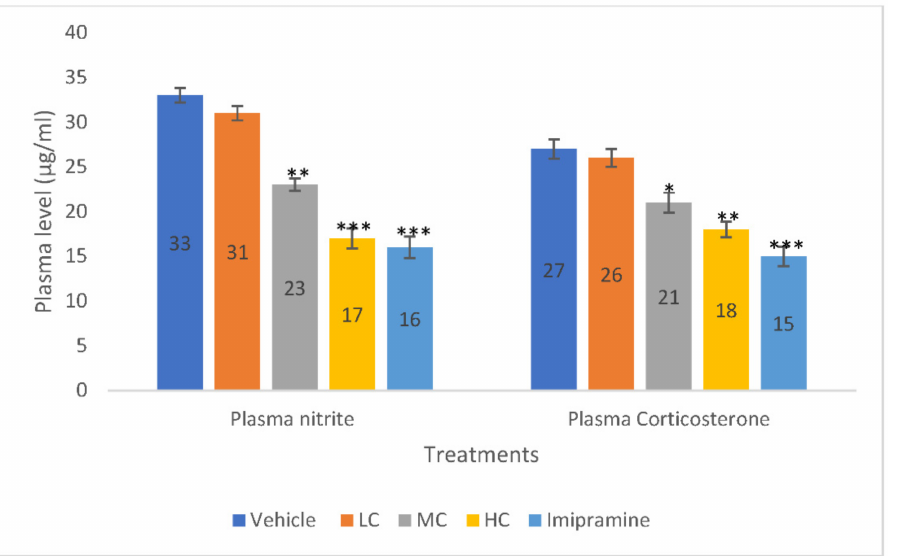
Figure 4. The changes on plasma nitrite and corticosterone levels due to crocin and imipramine. Data were given as mean and standard error of mean. Each group had eight animals. Statistical analysis was performed by one-way analysis of variance (ANOVA) and post-ANOVA Tukey’s test; * p < 0.05, ** p < 0.01, and *** p < 0.001 when compared to vehicle; LC—low dose of crocin; MC—medium dose of crocin; HC—high dose of crocin.